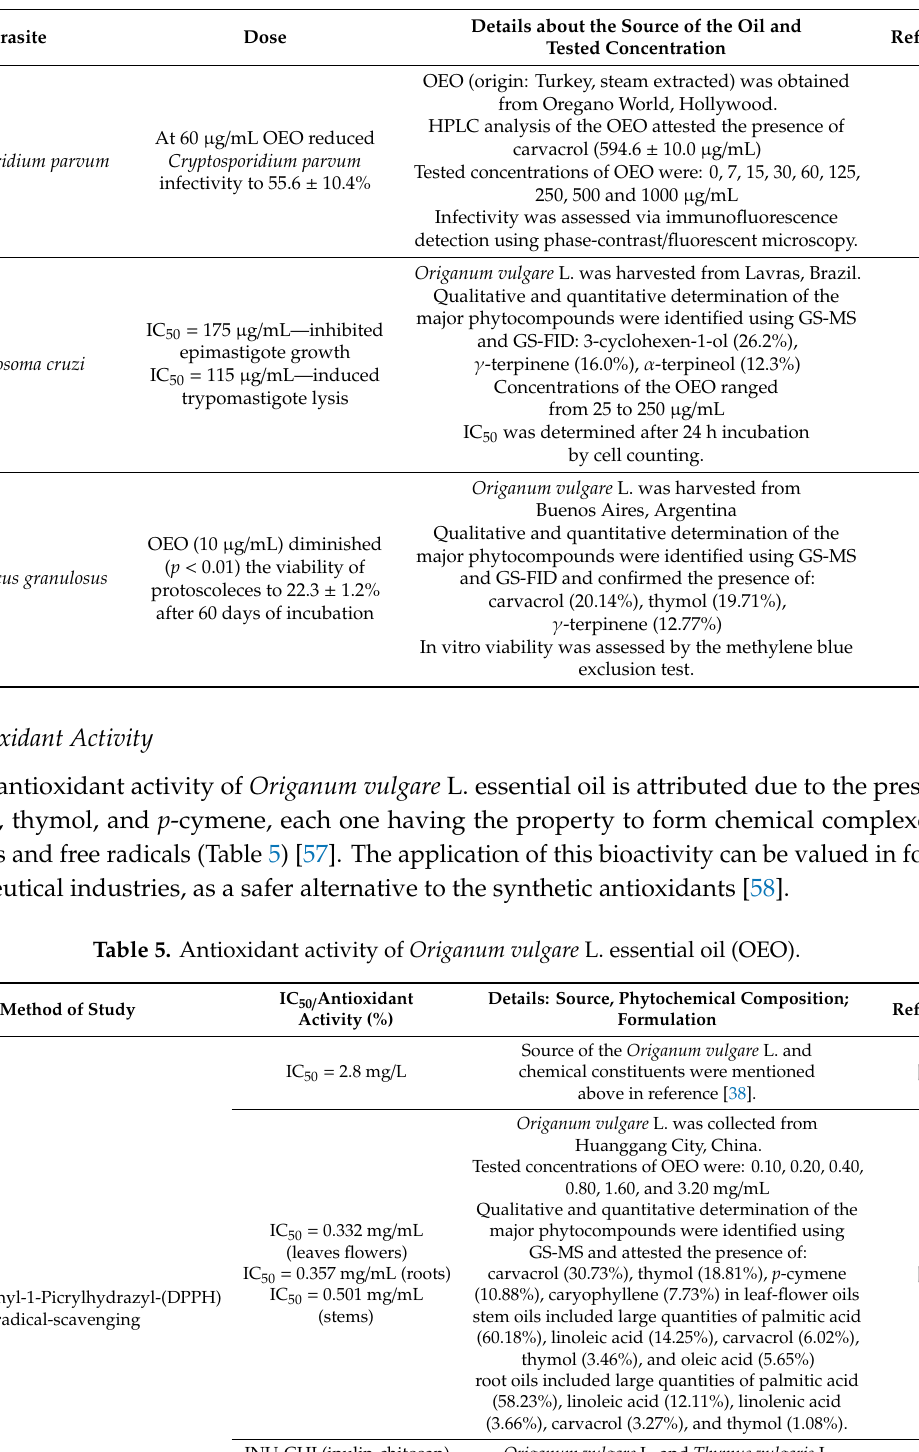
Table 4. Antiparasitic activity of Origanum vulgare L. essential oil (OEO).